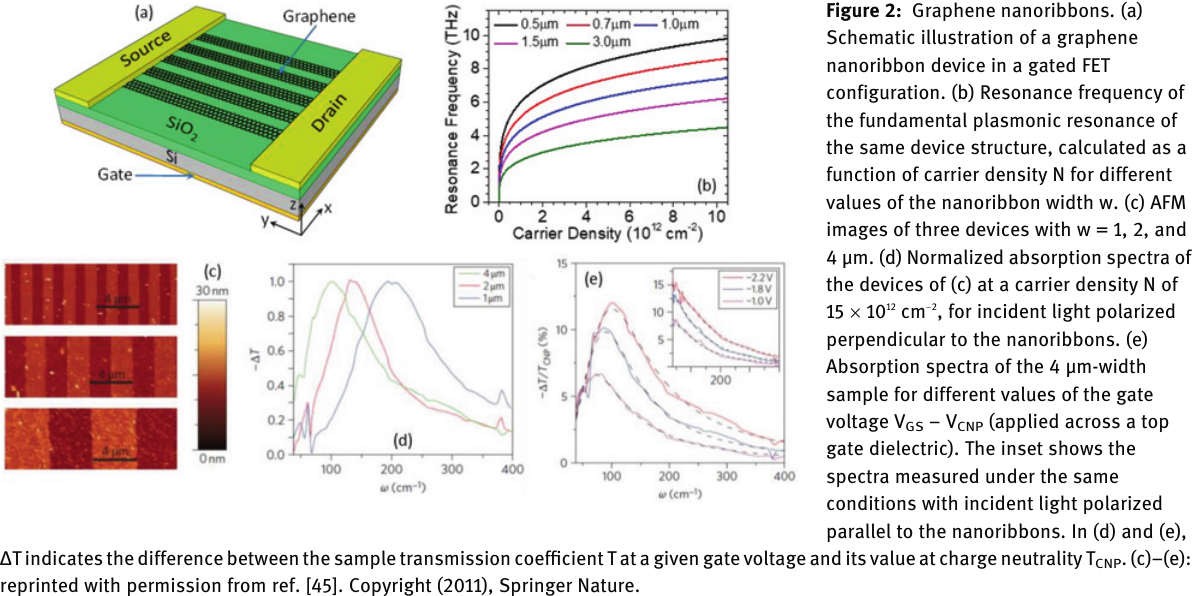
Figure 2: Graphene nanoribbons. (a) Schematic illustration of a